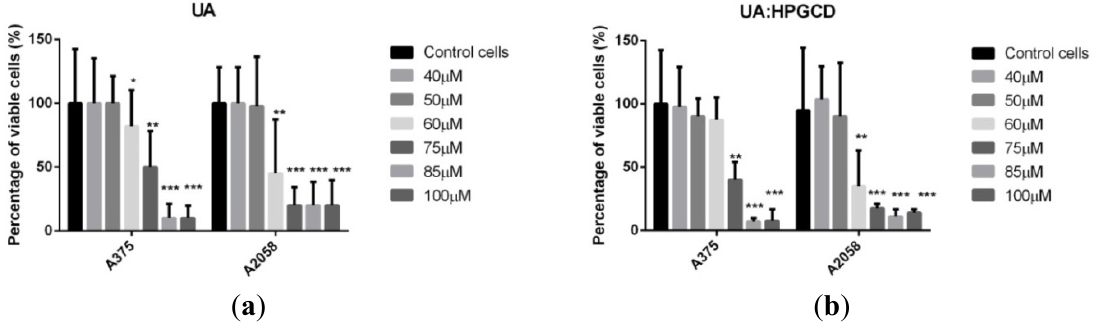
Figure 2. Alamar Blue assay showing the effects of ( a ) UA and ( b ) UA:HPGCD complex, respectively, on the viability of the A375 and A2058 human melanoma cell lines. Viability is expressed as percentage of viable cells compared to the control (considered as